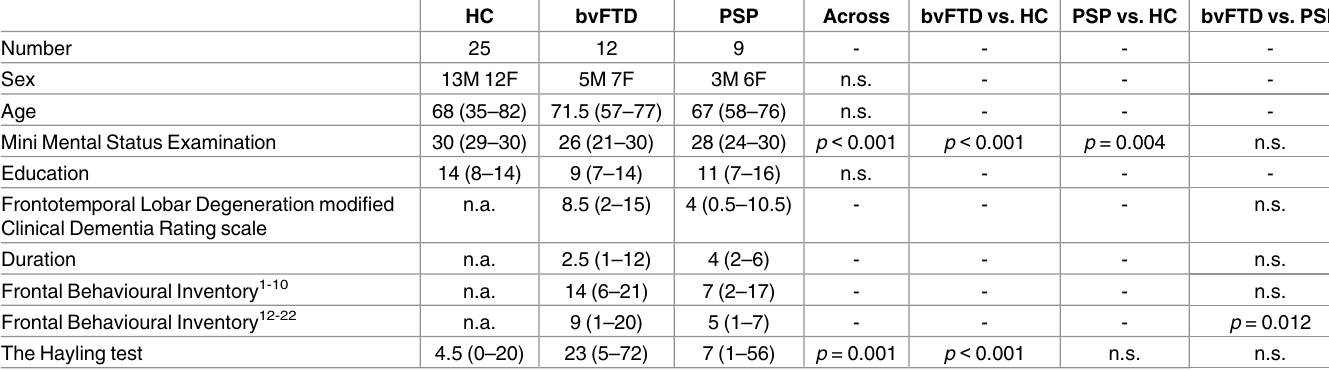
Table 1. Demographic and clinical data of